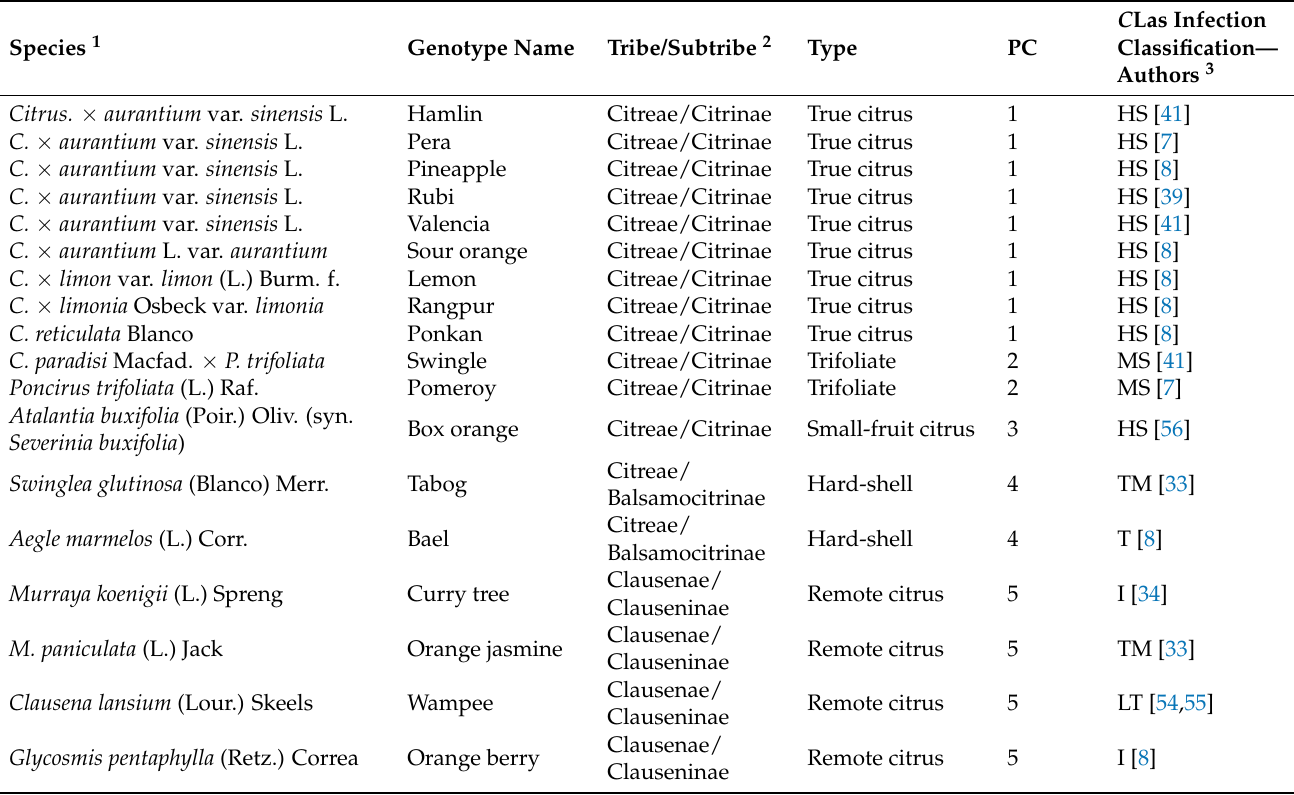
Table 1. Phylogenetic classification (PC) of the Aurantioideae species used in this